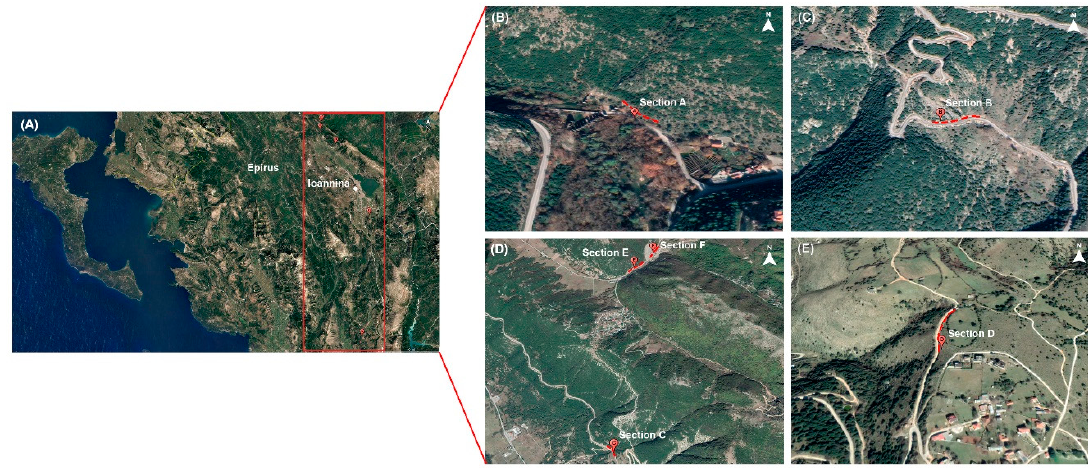
Figure 2. Google Earth maps of ( A ) Studied region in Epirus (NW Greece) into the red box; ( B ) Agios